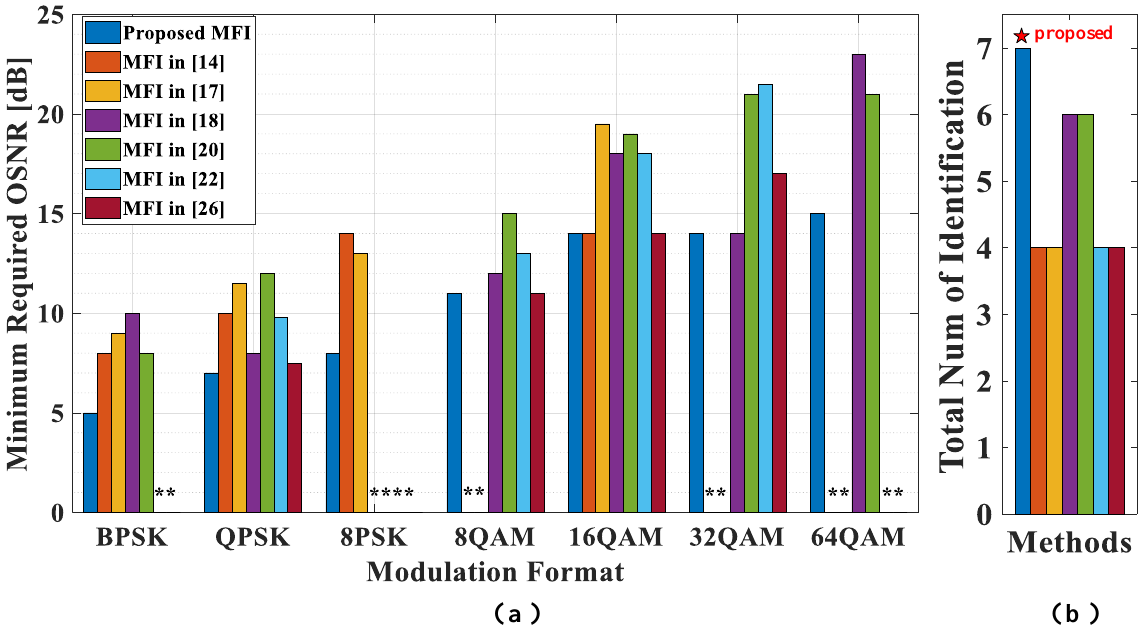
Figure 8. The identification accuracy of the proposed MFI.